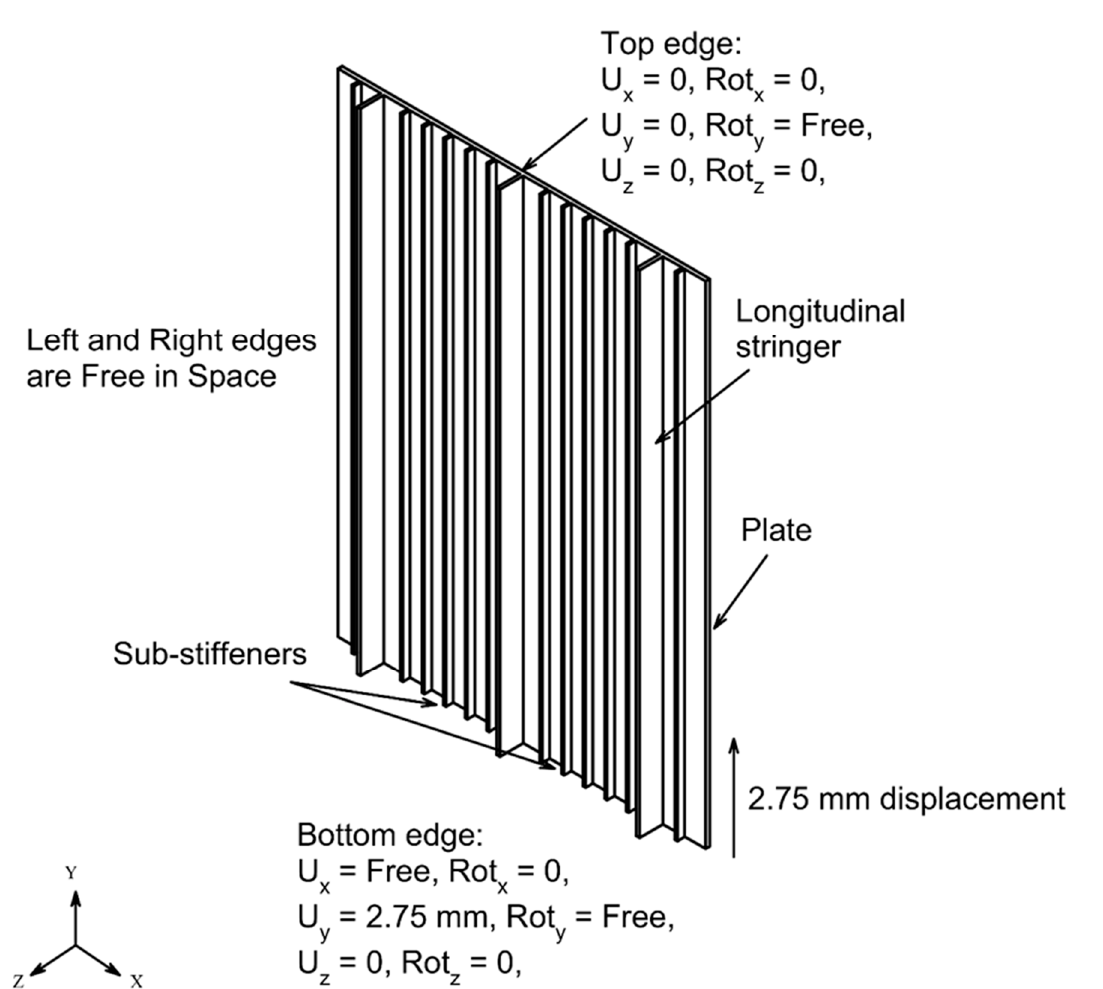
Figure 15. Nonlinear boundary condition on Specimen B.